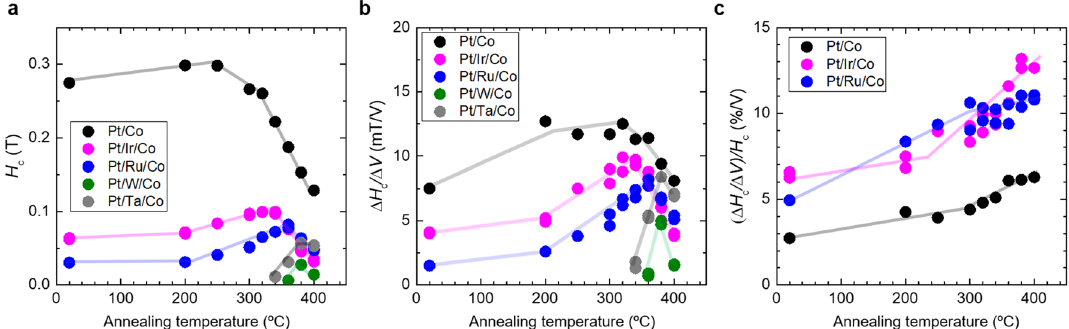
Figure 4. Annealing temperature-dependence of ( a ) H c , ( b ) Δ H c /Δ V , and ( c ) (Δ H c /Δ V )/ H c of the samples without and with heavy metal